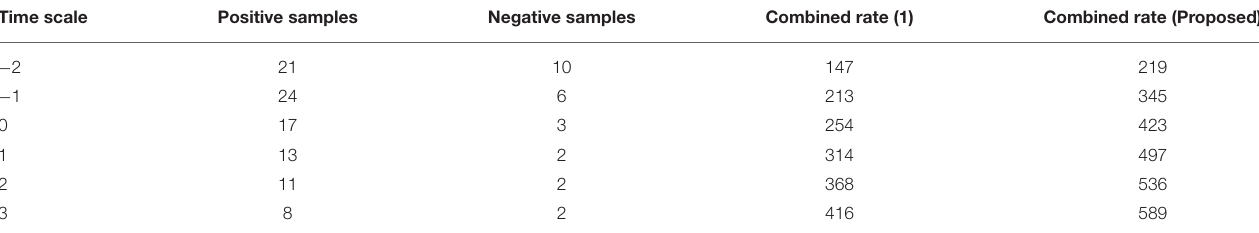
TABLE 2 | Combined rates of